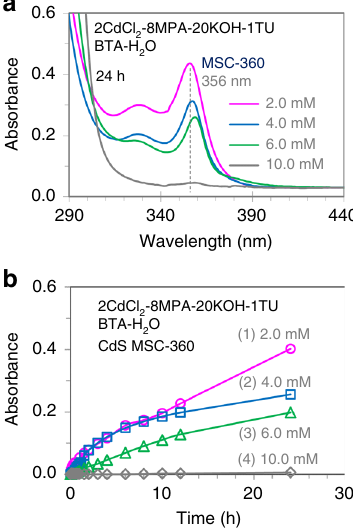
Fig. 3 Absorption properties of four solutions with four CdCl 2 concentrations. For the four solutions, the absorption spectra after 24 h of their preparation are shown in a and time-dependent absorbance of MSC- 360 is summarized in b . In the solvent of BTA (1.5 mL) and water (1.5 mL), the four mixtures have the feed molar ratio of 2CdCl 2 -8MPA-20KOH-1TU with the CdCl 2 concentrations of 2.0 (magenta trace for a and circular symbols for b ), 4.0 (blue trace for a and square symbols for b ), 6.0 (green trace for a and triangular symbols for b ), and 10.0 mM (gray trace for a and diamond symbols for b ). The spectra ( a ) are offset to have similar absorbance at 440 nm; the dashed line signi fi es the position of 356 nm. The absorbance of MSC-360 ( b ) is subtracted by the value at the corresponding wavelength evolved at 1 min; the solid lines in b are for visual guide. Obviously, the production of CdS MSC-360 is suppressed upon increasing the CdCl 2